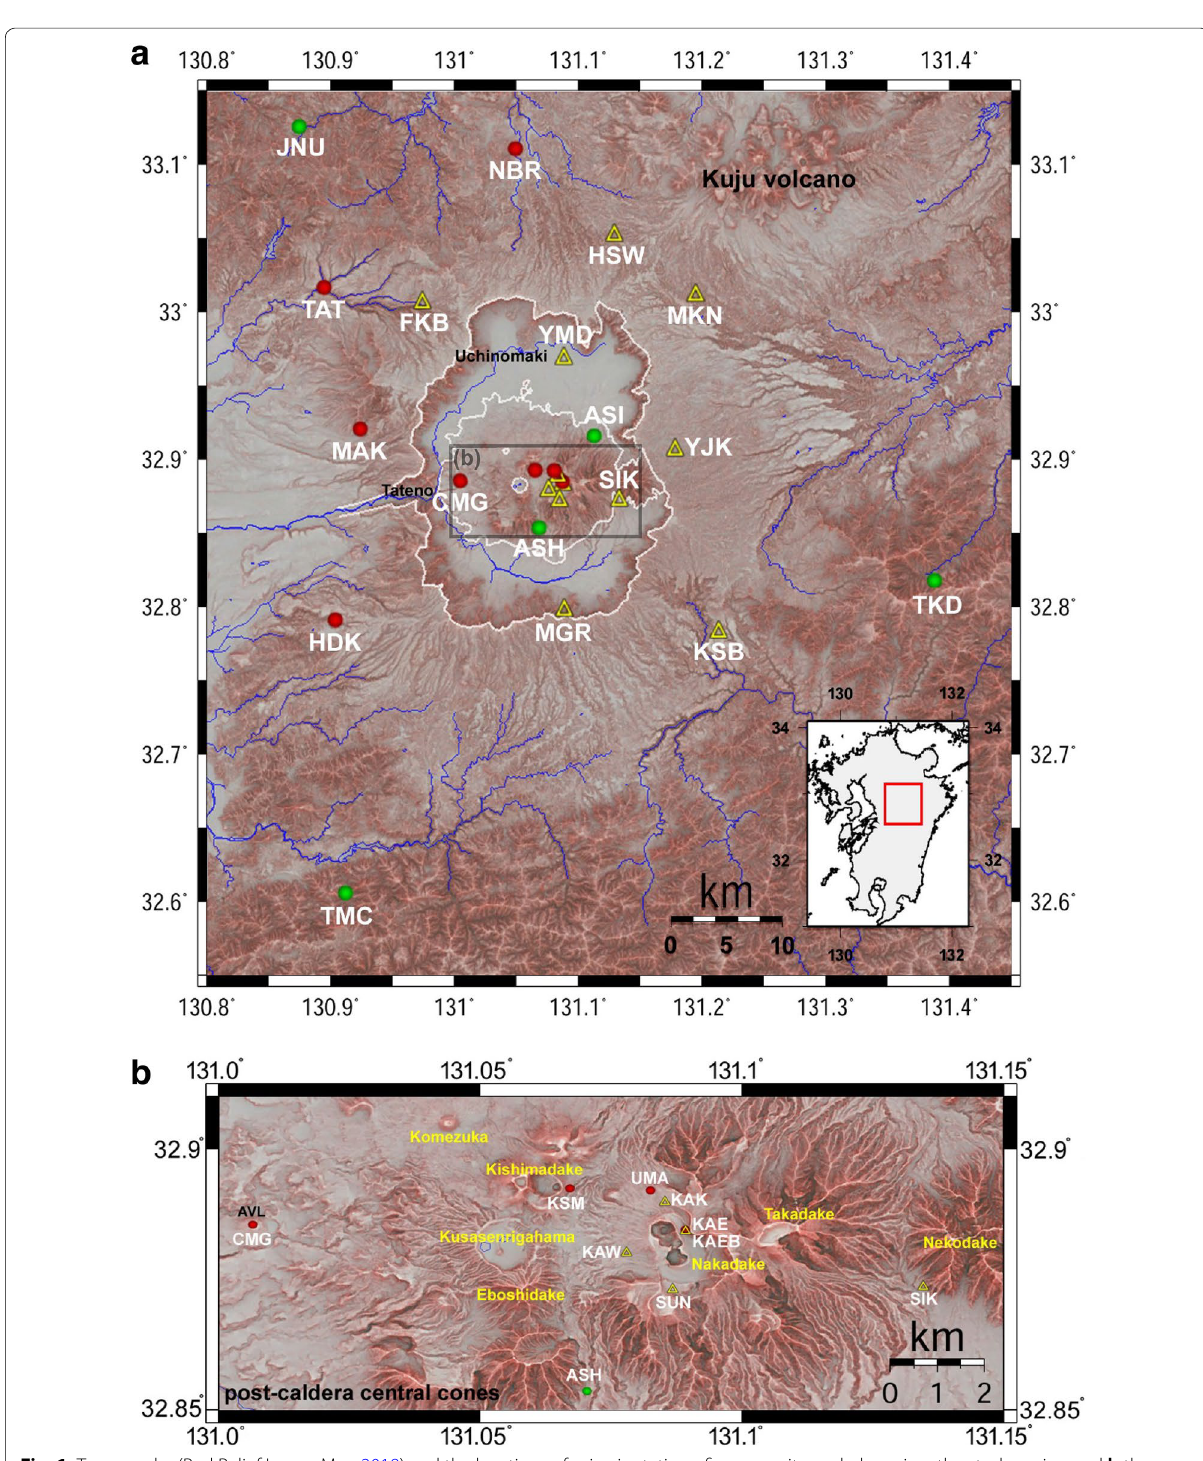
Fig. 1 Topography (Red Relief Image Map 2018) and the locations of seismic stations, five summits, and places in a the study region and b the post‑caldera central cones. The seismic network is composed of three sub‑networks, indicated by red circles (AVL BB stations), green circles (NIED and JMA BB stations), and yellow triangles (AVL SP stations). The inset shows the locations of the study regions (red box) in